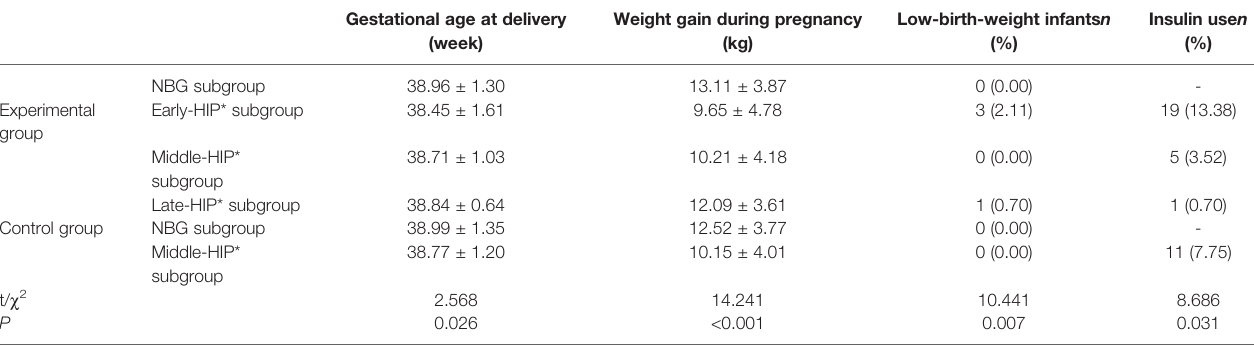
TABLE 6 | Comparison of perinatal outcomes among subgroups.